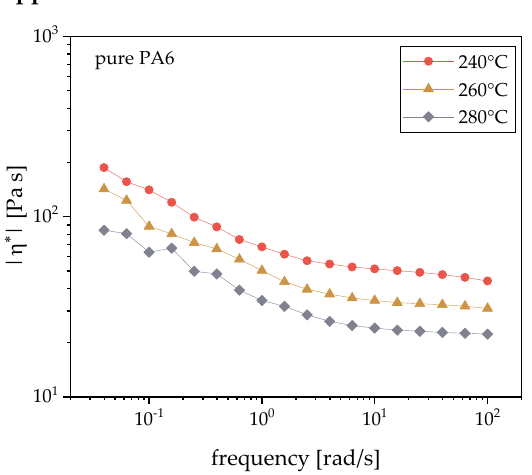
Figure A1. Complex viscosity | η *| of the pure polyamide 6 at 240 °C, 260 °C and 280 °C.